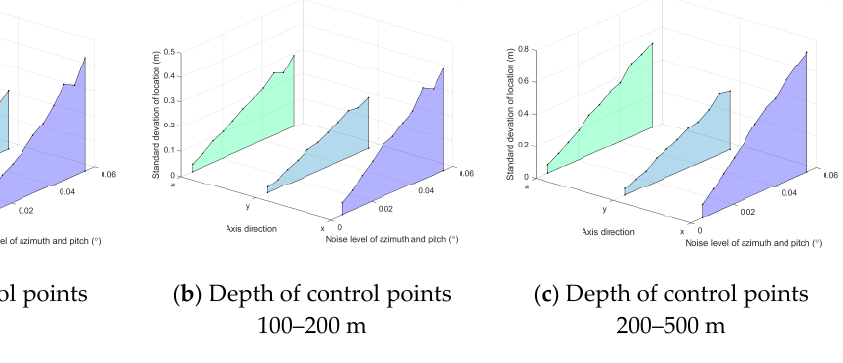
Figure 15. SDLE vs. angle noise σ angle